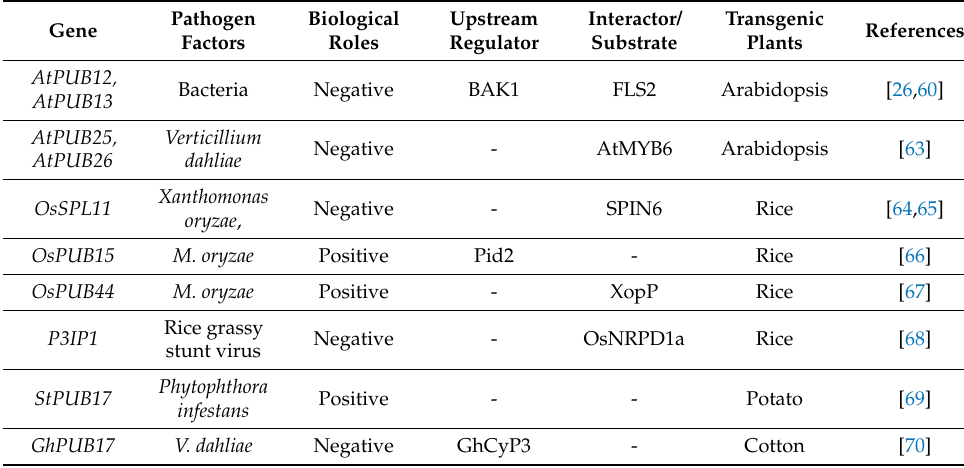
Table 3. PUBs Involved in the Response to Pathogen